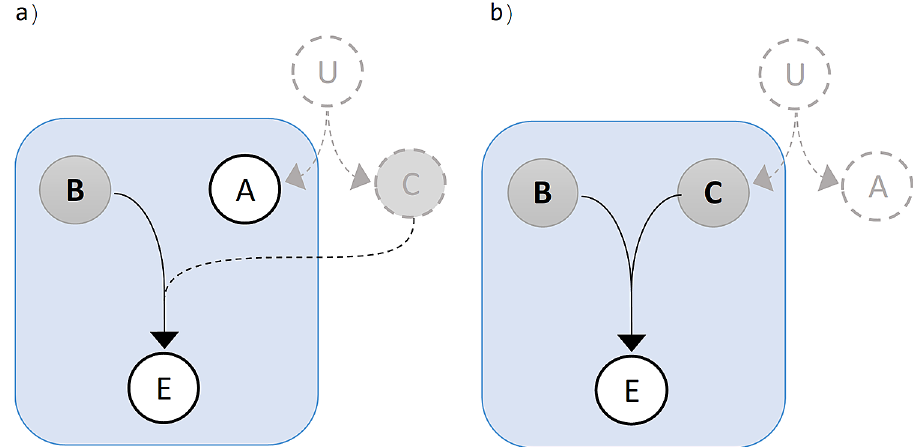
Figure 5. Interaction data of binary factors dichotomous effect E. Unknown mechanism U force the correlation between A and C. Factors B and C are jointly causative, while A is not causative. ( a ) Assessing the interaction of factors A and B, where factors C is not observed. ( b ) Assessing the interaction of factors A and C, where factors A is not observed. (Draw with PowerPoint 23